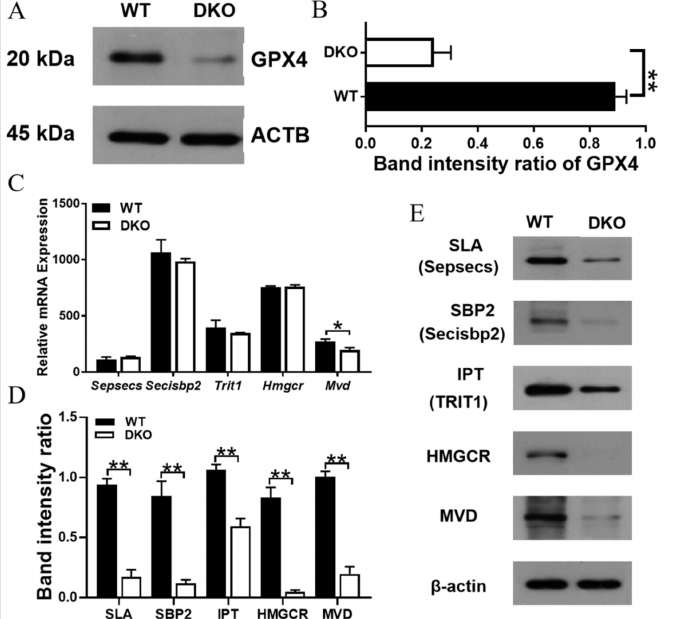
Figure 7. Analysis of GPX4 synthesis regulation in 14-month-old mice. ( A , B ) GPX4 protein expression in WT mice and DKO. Data are presented as mean ± SD, n = 2. ** p < 0.01. ( C ) Relative mRNA expression and protein expression ( D , E ) related to the pathway of mevalonate metabolism and selenoprotein synthesis in WT mice and DKO. Data are presented as mean ± SD, n = 3. * p < 0.05, ** p <